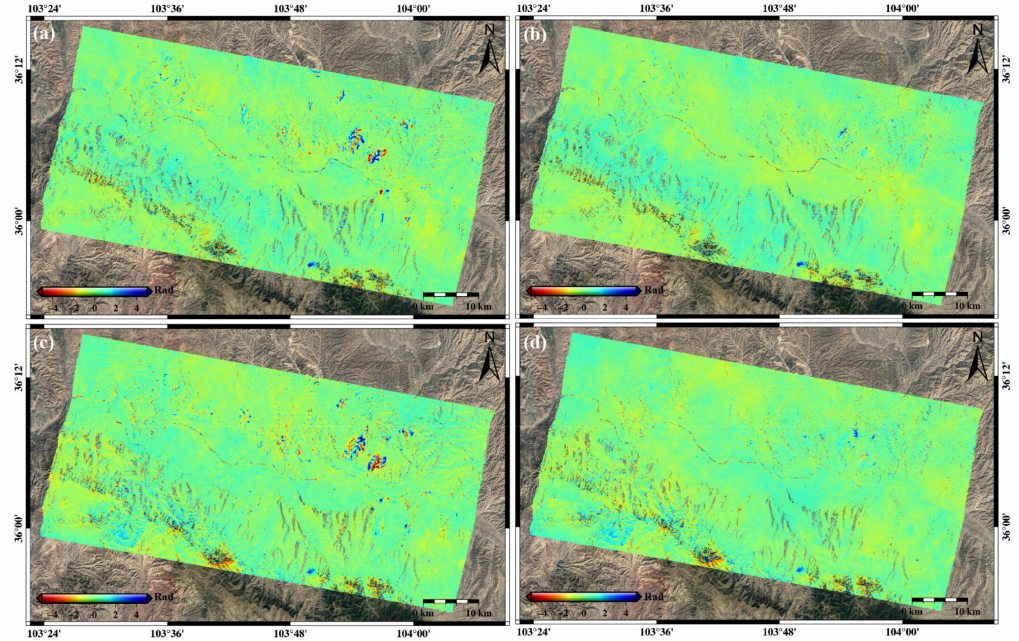
Figure 7. Exemplary unwrapped interferograms without (left) and with (right) DEM errors correction from descending Sentinel-1 images: ( a ) interferogram generated between 22 November 2018 and 16 December 2018 before DEM errors correction, with spatial and temporal baselines of − 127 m and 24 days, respectively; ( b ) the same interferogram after DEM errors correction; ( c ) interferogram generated between 23 November 2020 and 17 December 2020 before DEM errors correction, with spatial and temporal baselines of 158 m and 24 days, respectively; ( d ) the same interferogram after DEM errors